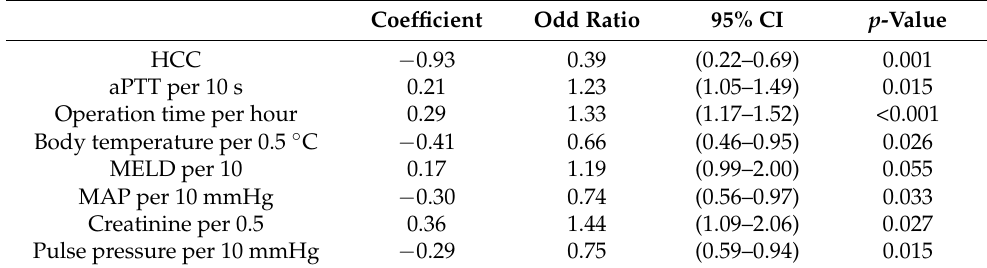
Table 3. Final logistic regression model.